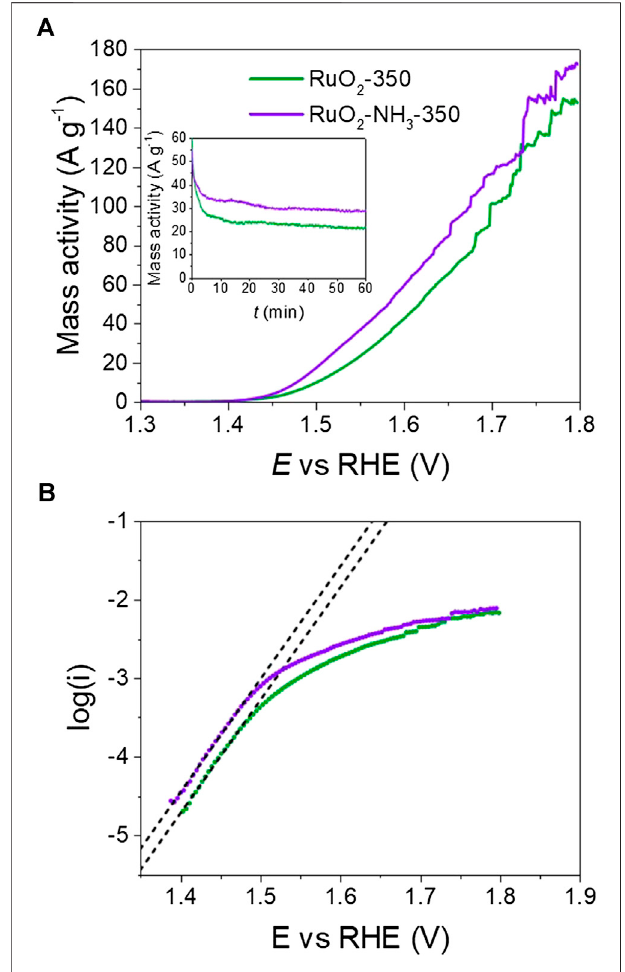
FIGURE 8 | (A) Polarization curves for oxygen evolution reaction (OER) on C-RuO 2 (green line) and A-C-RuO 2 (purple line) recorded in 0.50 mol L − 1 H 2 SO 4 at a scan rate s (cid:2) 0.010 V s − 1 and T (cid:2) 25 ° C. Inset: corresponding chronoamperometric curves for the OER recorded at E (cid:2) +1.600 V vs. RHE. (B) Tafel plots of C-RuO 2 (green circles) and A-C-RuO 2 (purple